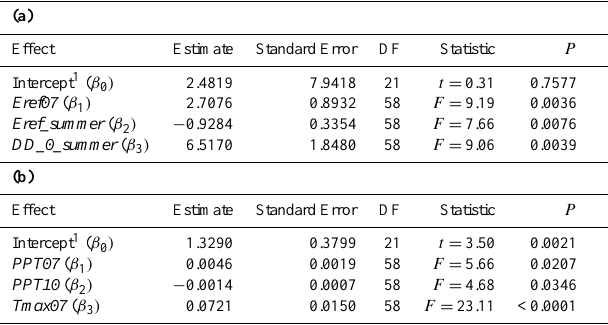
Table 3. Parameter estimates and statistical tests for the climatic variables-based hierarchical models regarding seed dormancy and weight; (a) seed dormancy model; (b) seed weight